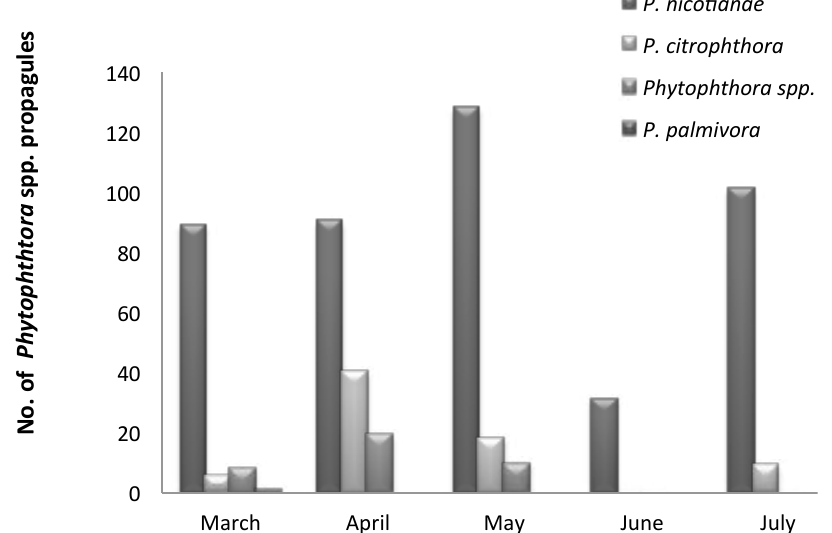
Figure 6. Number of Phytophthora spp. propagules/gram (ppg) of different Phytophthora species during the monitoring period isolated from soil and root samples in Nursery 1 and Nursery